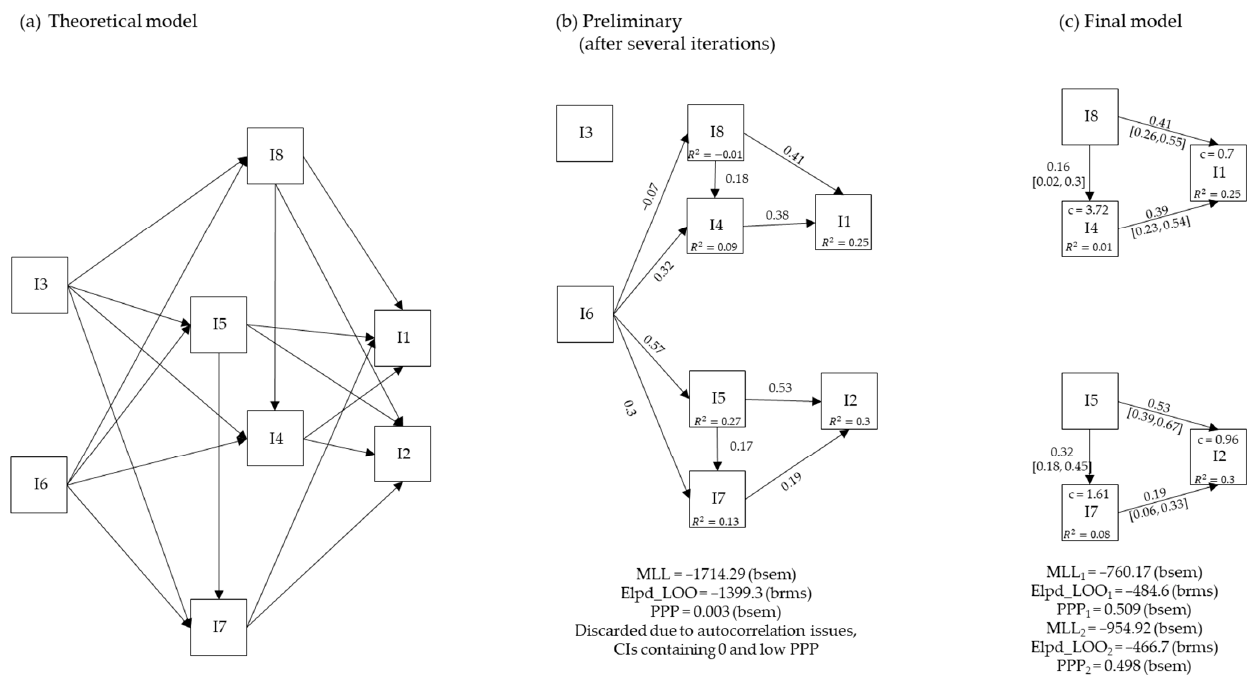
Figure 2. Structural models of conflicts at work. Notes: model parameters calculated using R, package brms (4 chains, each with iter = 4000; warmup = 2000; total post-warmup draws = 8000), additional model fit parameters calculated with package bsem (estimator: Bayes; optimization method: NLMINB; Warmup = 500; Iter = 1000). Variables’ abbreviations and their meaning: I1—positive conflicts’ consequences, I2—negative conflicts’ consequences, I3—sources of the conflict related to the cognitive conflict type, I4—efficient conflict management strategy, I5—negative affective